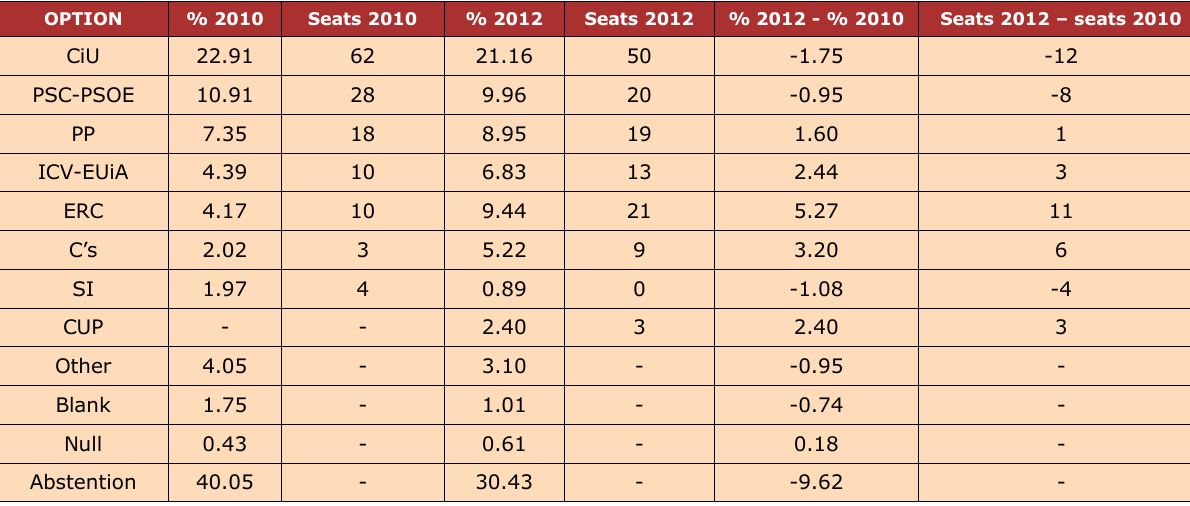
Table 3. Main global results of the elections to the Catalan Parliament held in 2010 and 2012